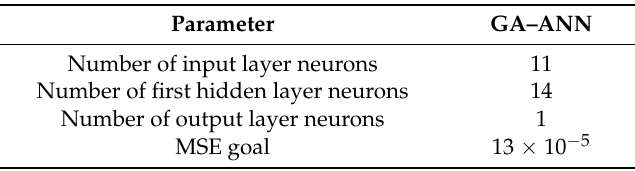
Table 1. Values of parameters used in GA–ANN